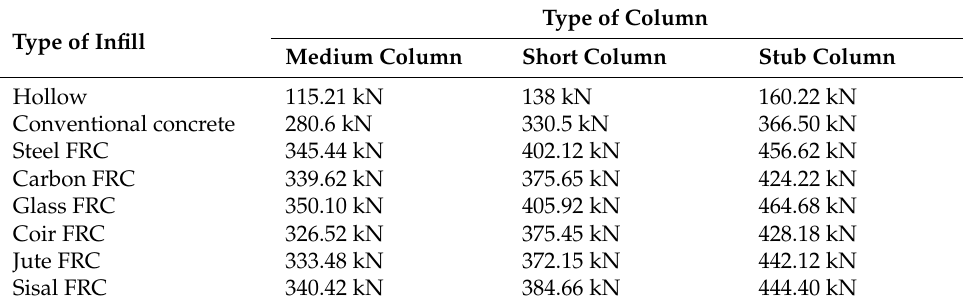
Table 2. Ultimate load of various CFST